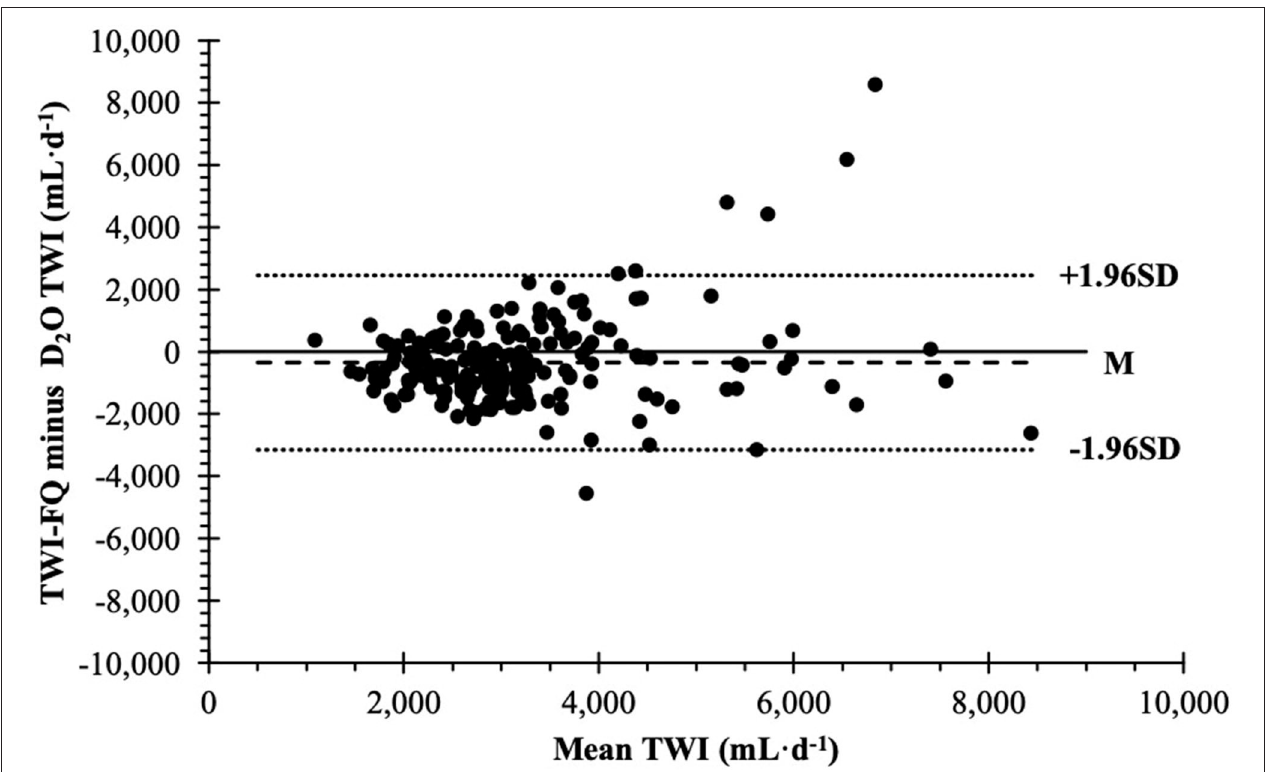
FIGURE 2 | Bland-Altman plot of agreement between total water intake frequency questionnaire and deuterium oxide dilution method to estimate mean daily total water intake during two, one-week periods ( n 196). TWI, mean daily total water intake; TWI-FQ, total water intake frequency questionnaire; D 2 O, deuterium oxide = dilution method; M, mean difference between methods (bias); SD, standard deviation of the mean